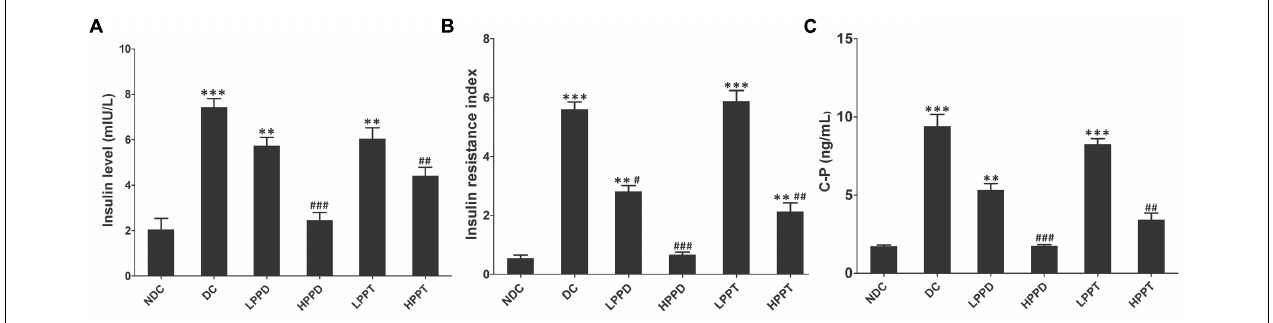
FIGURE 5 | PPT and PPD ameliorates insulin level in high-fat diet and STZ-induced diabetic mice. (A) Serum insulin content, (B) HOMA-IR, (C) C peptide level. ∗ p < 0.05, ∗∗ p < 0.01, ∗∗∗ p < 0.001, vs. NDC group; # p < 0.05, ## p < 0.01, ### p < 0.001 vs. DC group. Different groups were significantly different ( p < 0.05).